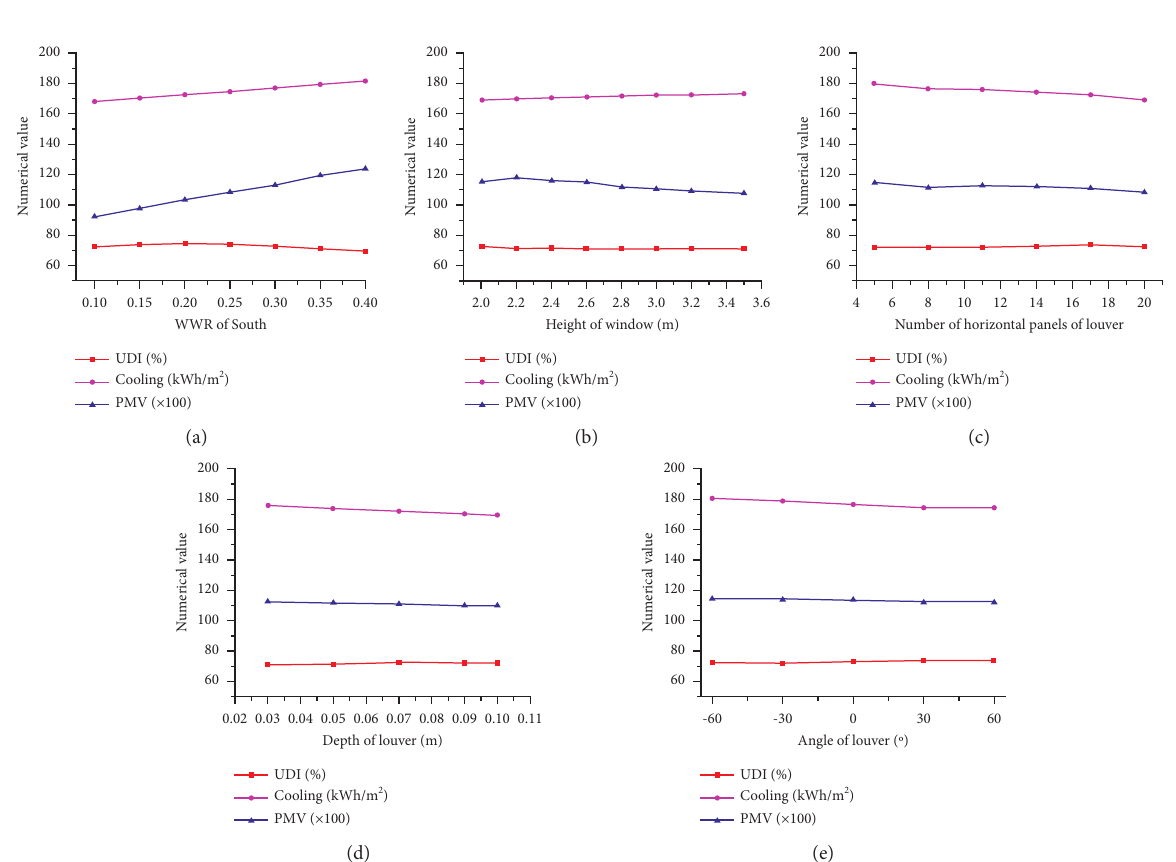
Figure 7: Influence of independent variable on three target values. (a) Target value change is caused by the WWR variable on the south side; (b) window height variable causes the target value to change; (c, d, e) number of horizontal panels, depth, and angle of louvers cause the target value to